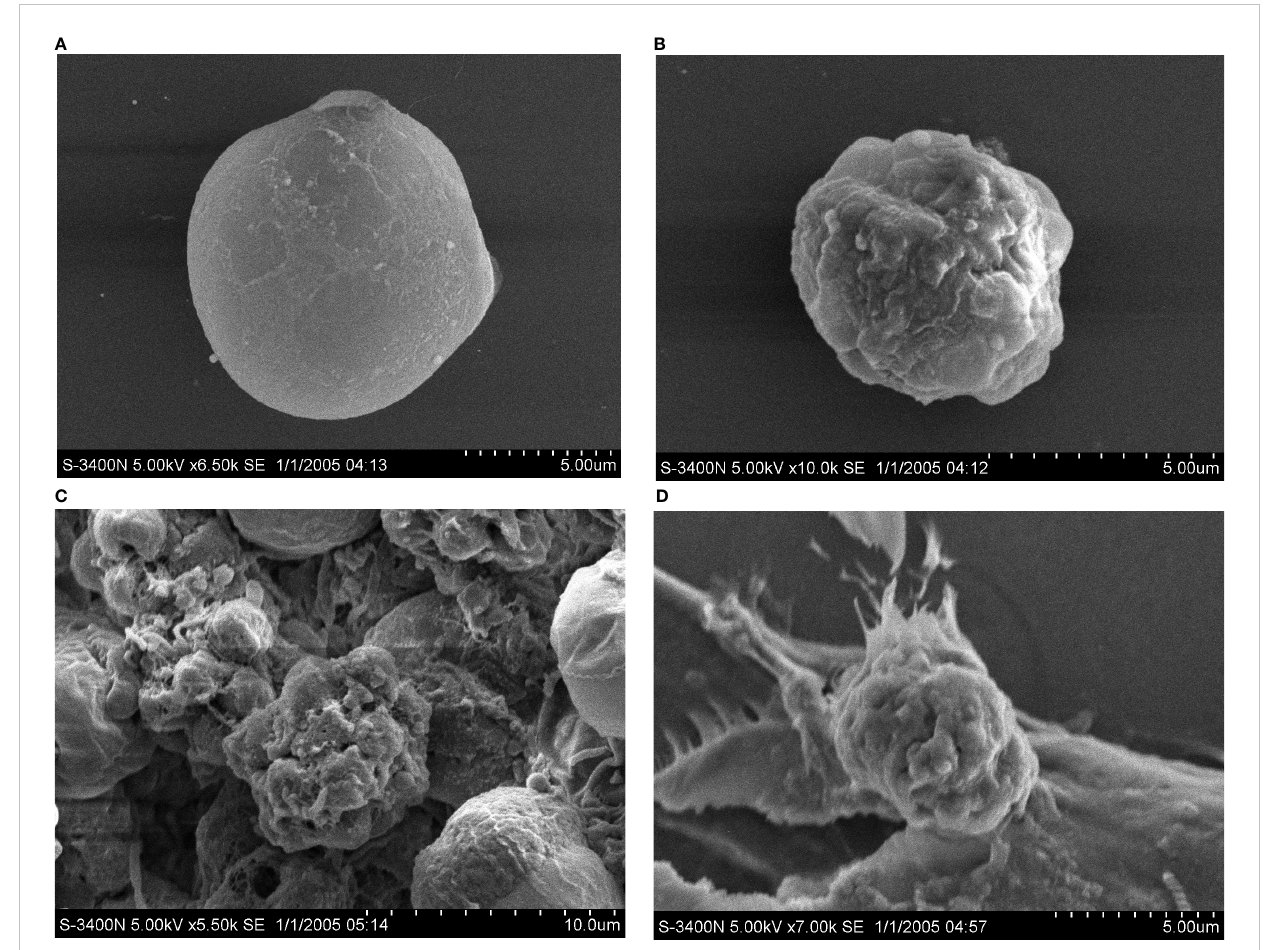
FIGURE 5 Morphological changes Heterosigma akashiwo treated with algicidal substances observed by scanning electron microscopy after 0h (A) , 0.5h (B) , 4h (C) and 24h (D)